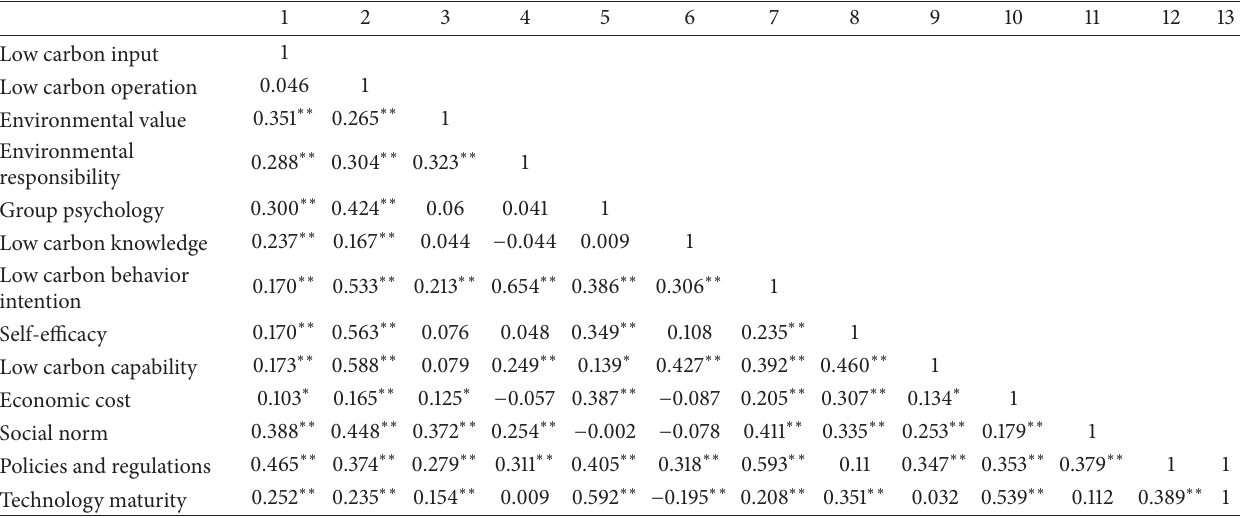
Table 2: The correlation matrix between low carbon logistics behavior and influence